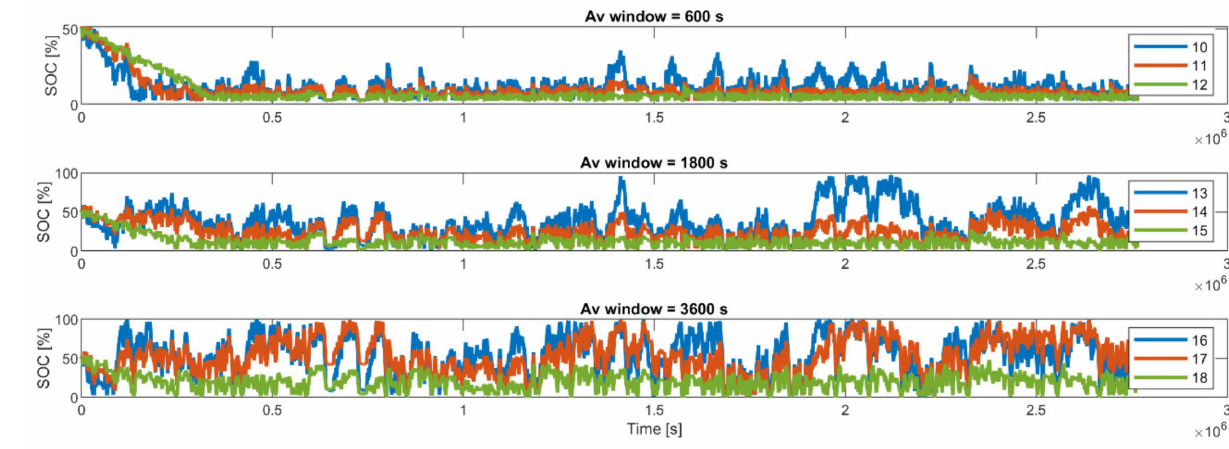
Figure 15. The SOC trend over time (cases 10–18).